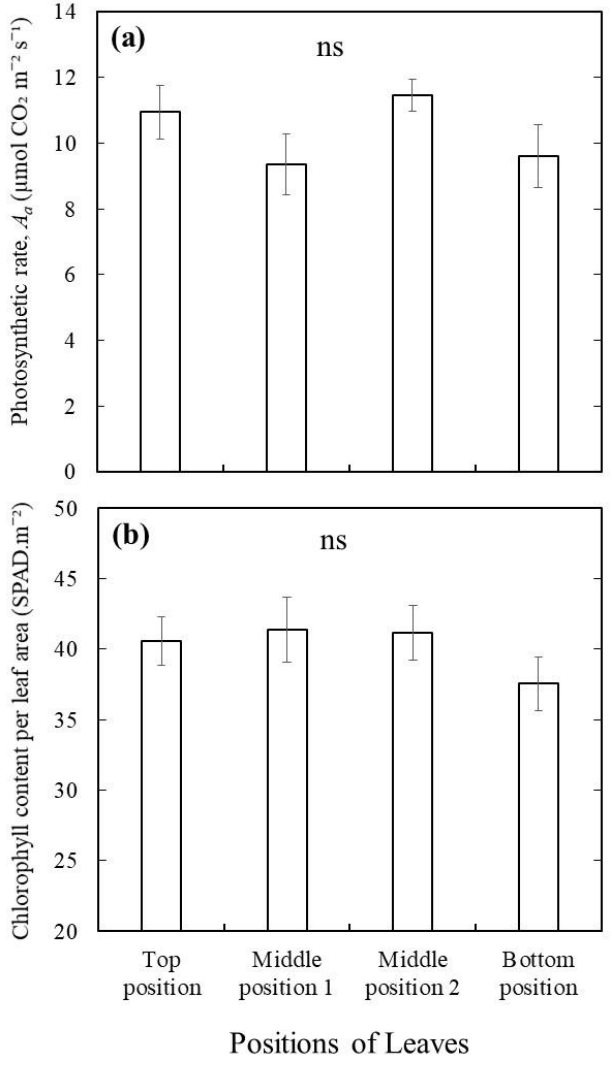
Figure 4. Comparison of photosynthetic rate ( a ) and chlorophyll content ( b ) of leaves from four different positions (from top to bottom) of a single stem from five different genotypes of wild blueberry plants ( Vaccinium angustifolium ). Bars are means ± SEs ( n = 5 different genotypes); ns means no significant difference at p < 0.05.